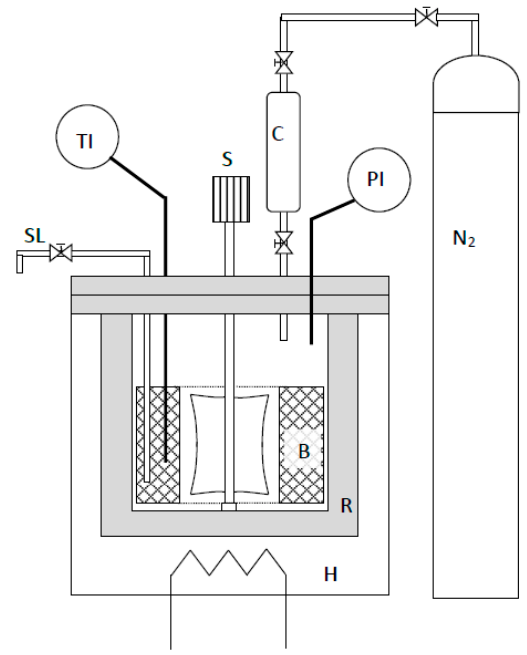
Figure 3. Experimental batch reactor. R: reactor; H: electrical heating mantle; B: annular stationary basket container; S: magnetically driven stirrer; TI: temperature indicator; PI: pressure indicator; C: stainless steel container for methanol addition; and, SL: sampling